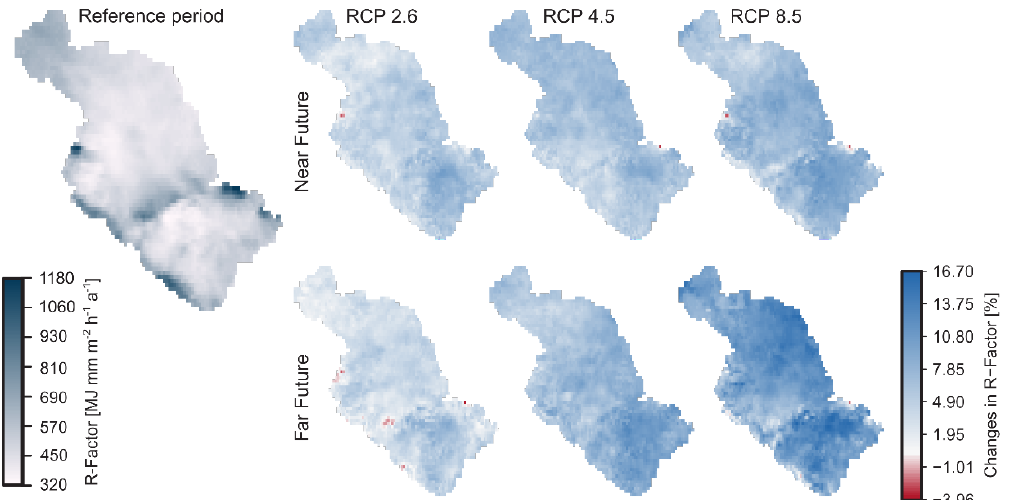
Figure 5. Projected changes in rainfall erosivity for the near future (2031–2060) and the far future (2071–2100) with respect to the reference period 1971–2000. The figures show the median of all simulations in the German Weather Service’s reference ensemble for the emission scenarios RCP 2.6, 4.5 and 8.5. Maps of the 15th and 85th percentile of the ensemble simulations are shown in Figures S1 and S2 in the supplementary material.